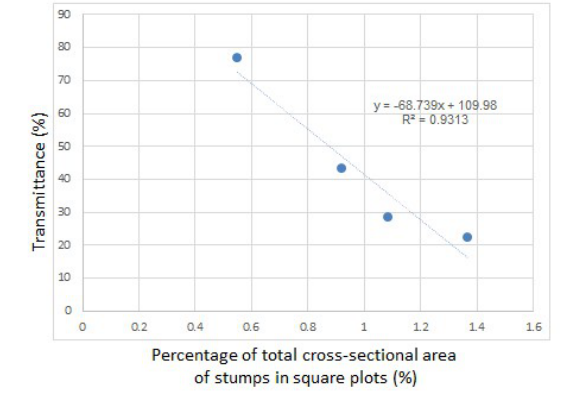
Figure 14 . Relationship between LiDAR data and every tree survey with inclination correction.